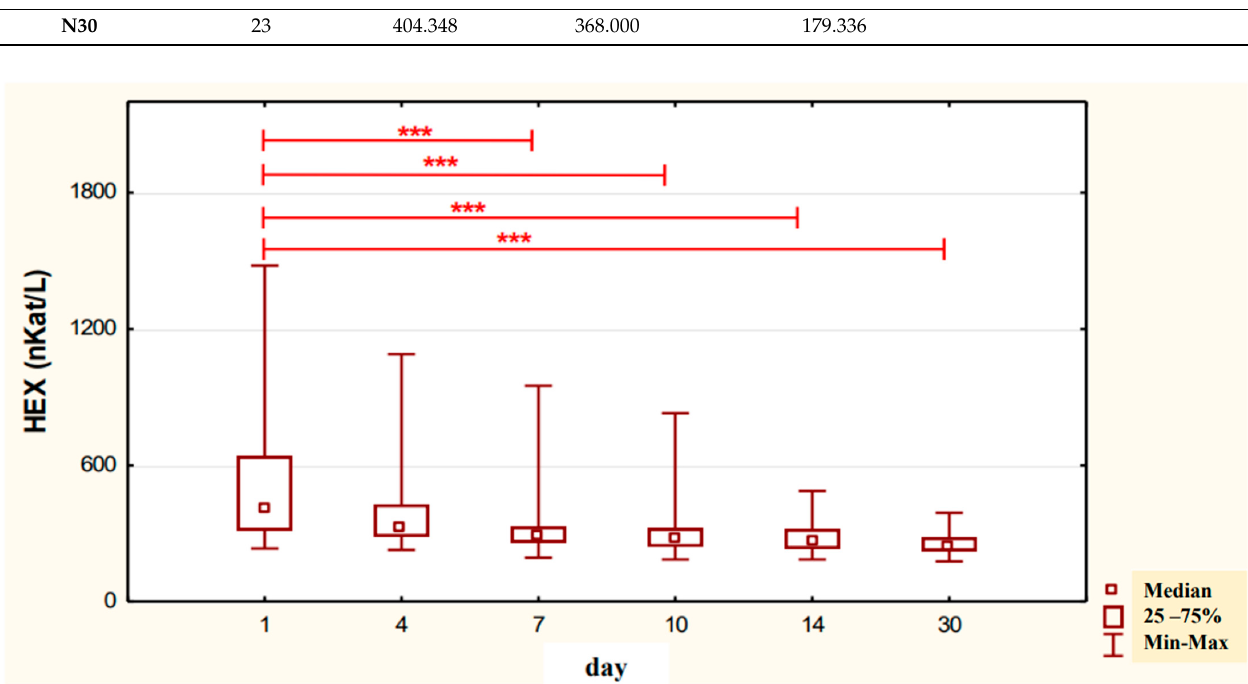
Figure 1. Variability over time in the concentration of serum HEX activity (nKat/L) of control group patients addicted to alcohol but not treated with neoglandin (K); *** p < 0.001.